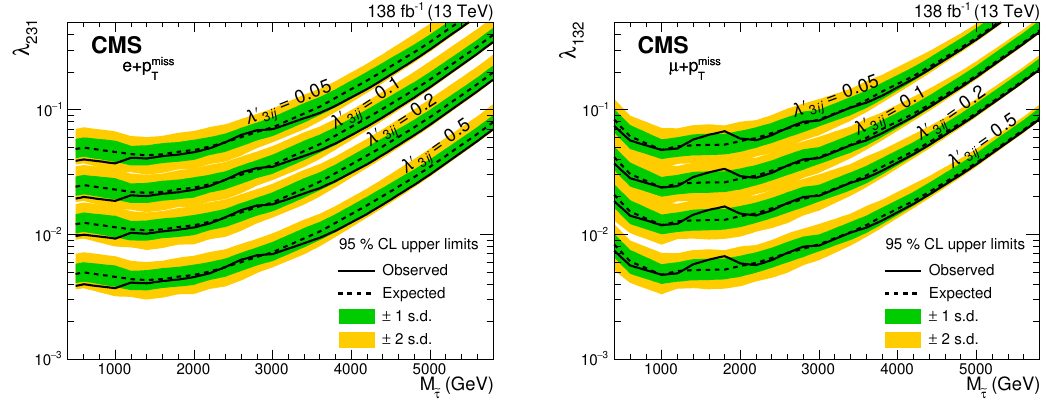
Figure 9 . The observed (solid line) and expected (dashed line) upper limits at 95% CL on the couplings λ (left) and λ (right), for several values of λ 0 ( i, j = 1, 2, 3), as a function of the 231 132 3 ij mass of the mediator in the RPV SUSY model. The one and two standard deviation uncertainty e t bands for the expected limits are shown. The areas above the limit curves are